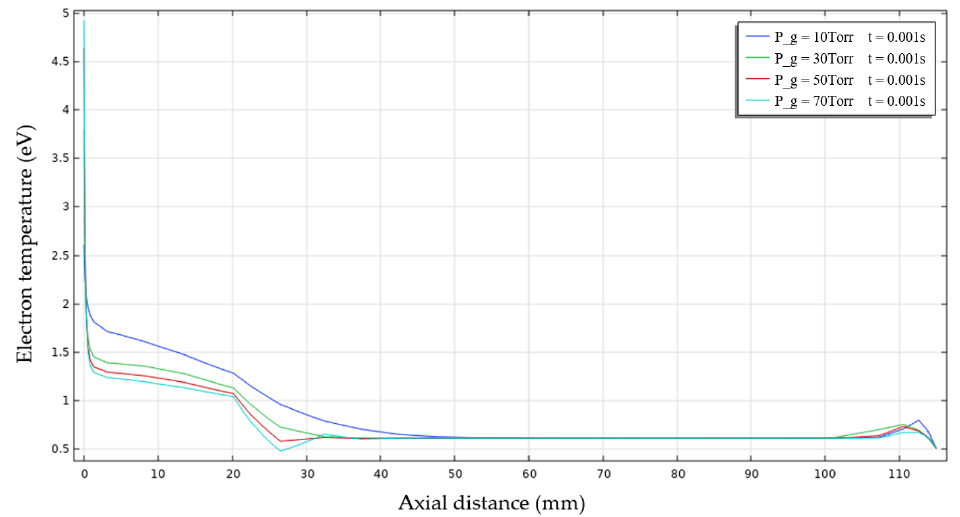
Figure 11. Axial electron temperature distribution in the deposition